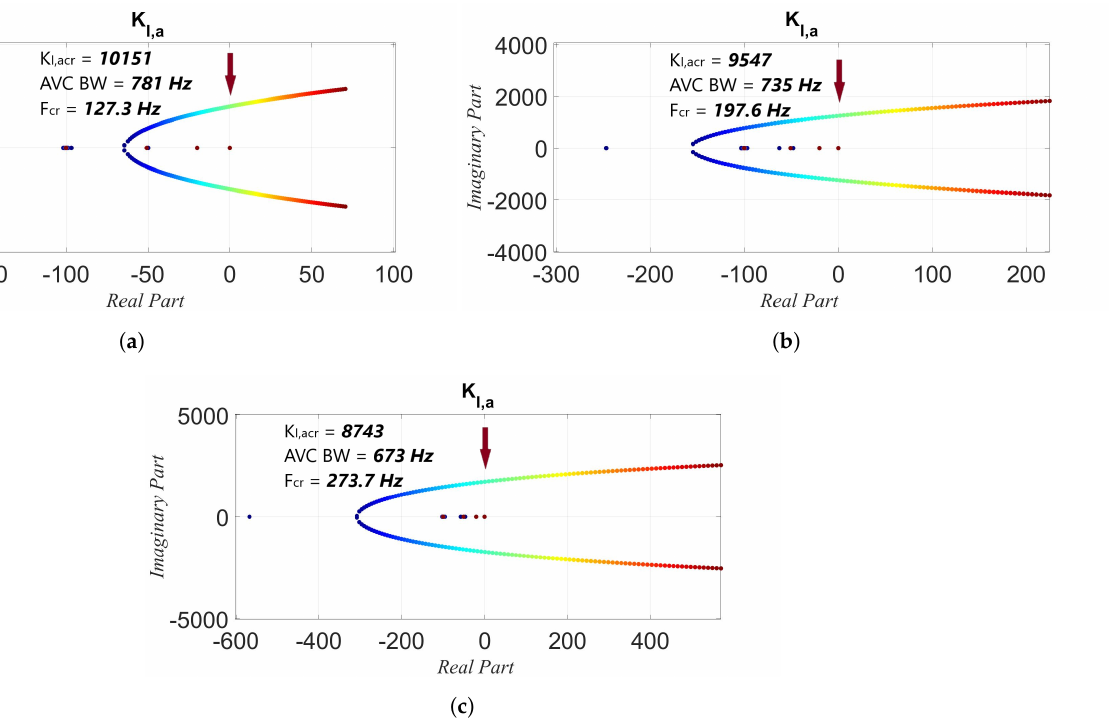
Figure 10. Eigenvalue − based stability analysis for different AVC filter cases in the strong grid case scenario (SCR = 10). The critical bandwidth of the AVC is identified after K I , a 0 varies from 1 (deep blue) to 200 (deep red) times. ( a ) f AVC,LPF = 20 Hz ( b ) f AVC,LPF = 50 Hz ( c ) f AVC,LPF = 100